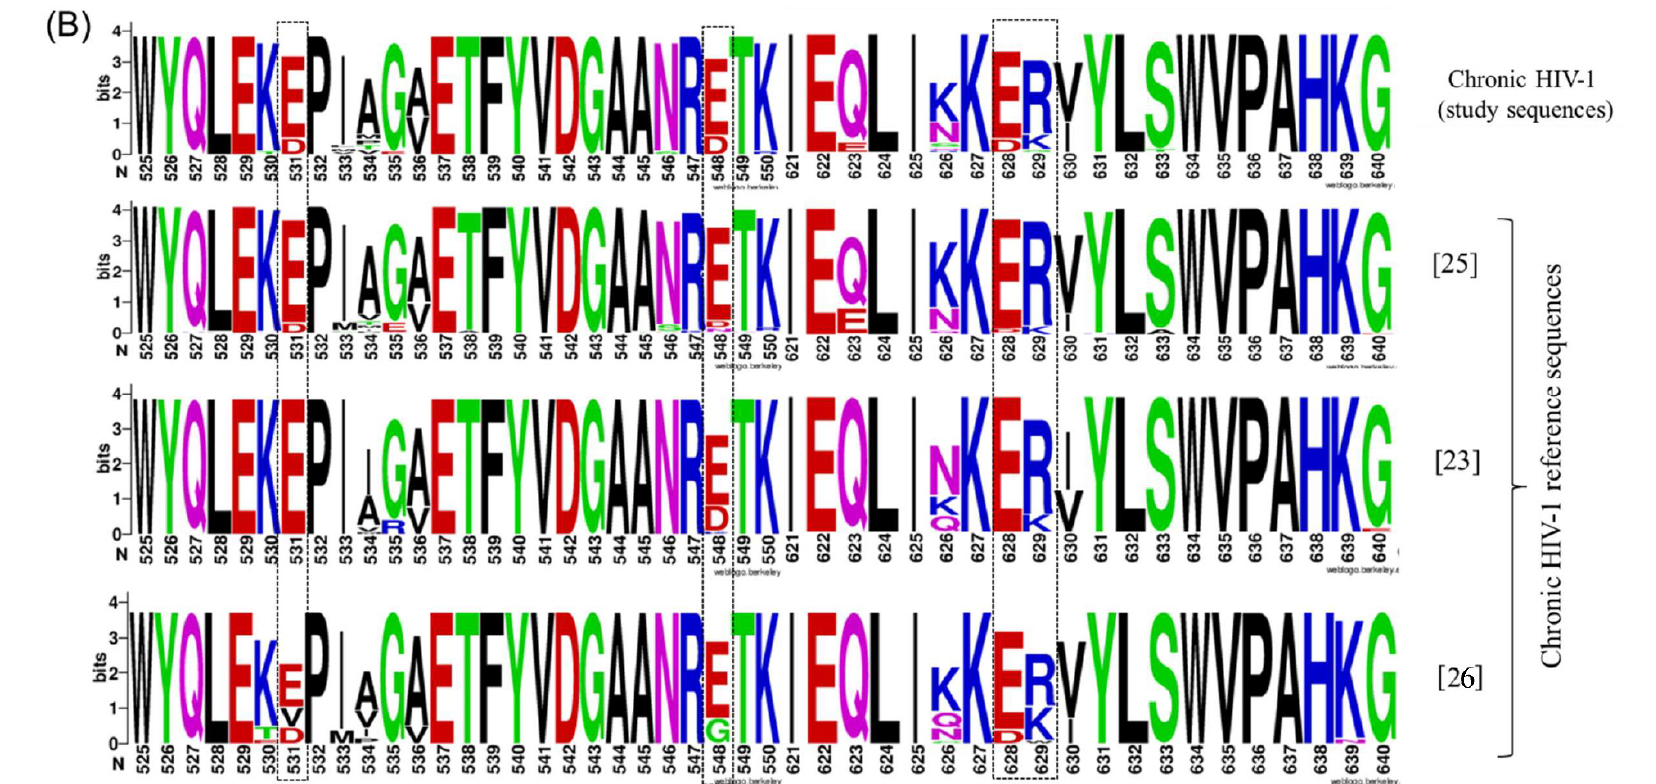
Figure 3. Amino acid mutations (E531, E548, E628 and R629) identified in study sequences to be highly conserved during recent HIV-1 stage compared to chronic HIV stage. ( A ) Comparison of these amino acid mutations with subtype C reference sequences obtained during recent HIV-1 infection [21–24]. ( B ) Comparison of these amino acid mutations with subtype C reference sequences obtained during chronic HIV-1 infection [23,25,26]. Image created in WebLogo 3.7.4. HIV = human immunodeficiency virus.